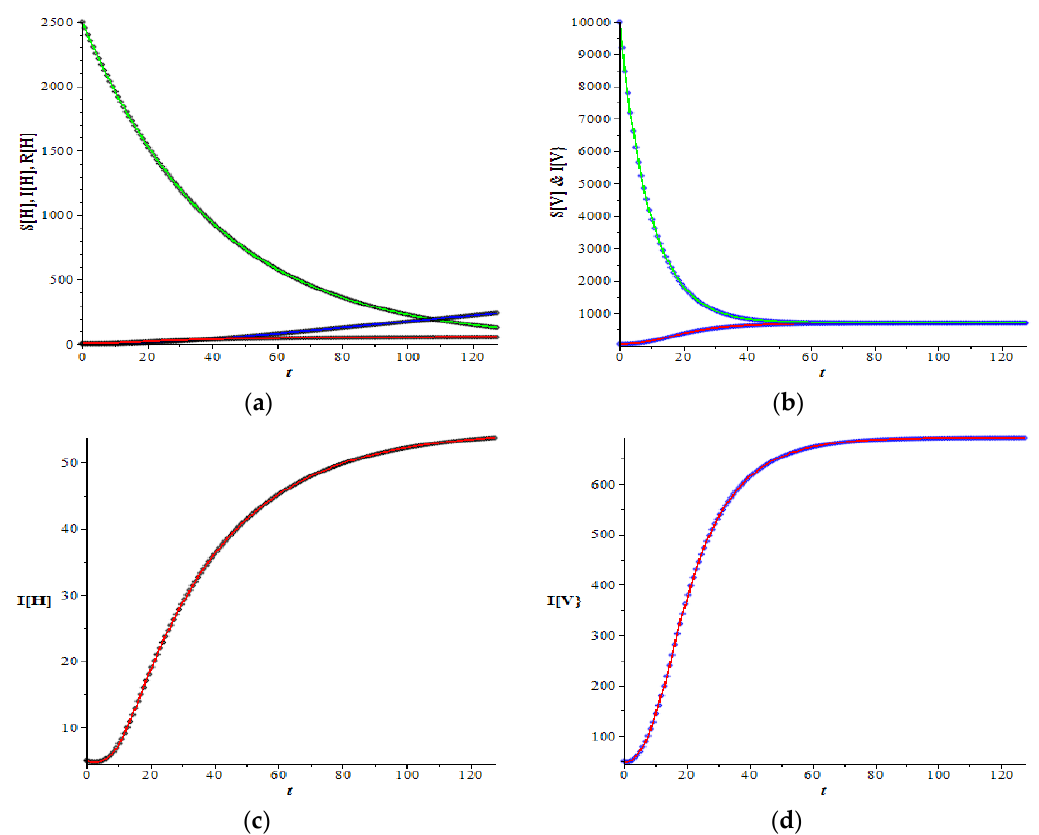
Figure 1. ( a ) shows the graphs of S H ( t ) , I H ( t ) , and R H ( t ) , indicated respectively by green, red, and blue line colors for a very large basic reproduction number ( R 0 = 166.321), while ( b ) shows the graphs of S V ( t ) and I V ( t ) , indicated by green and purple line color for the same parameters as in ( a ). ( c , d ) provides a zoomed in version of I H ( t ) and I V ( t ) graphs.